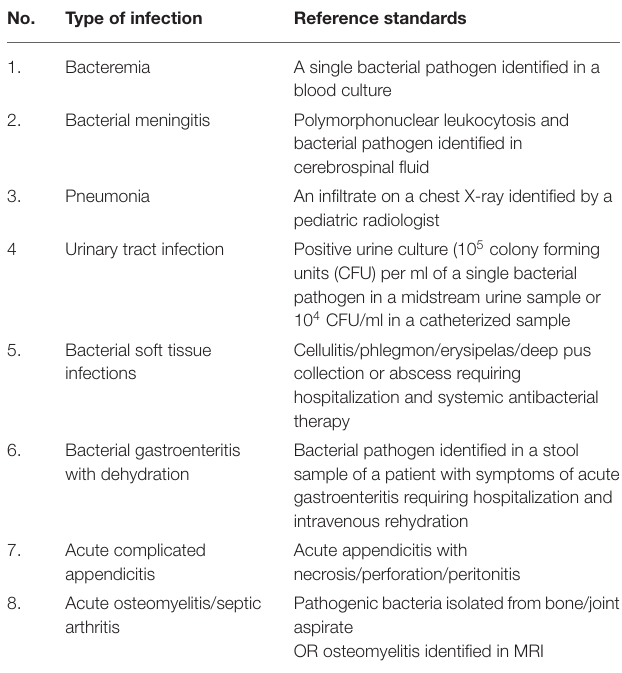
TABLE 1 | Definitions and reference standards for SBI used in the